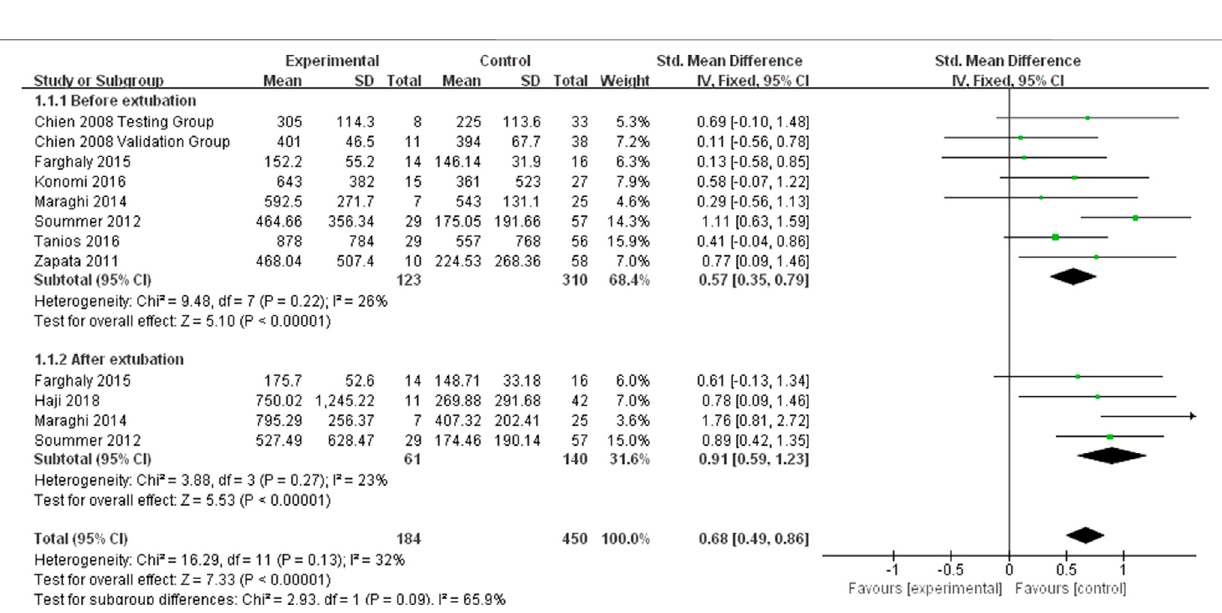
Frontiers in Physiology |